Question: According to the figure, is the described quantity increasing or decreasing?
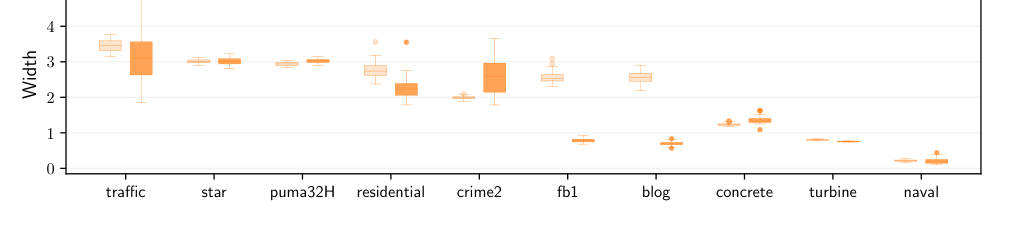
Answer: increasing